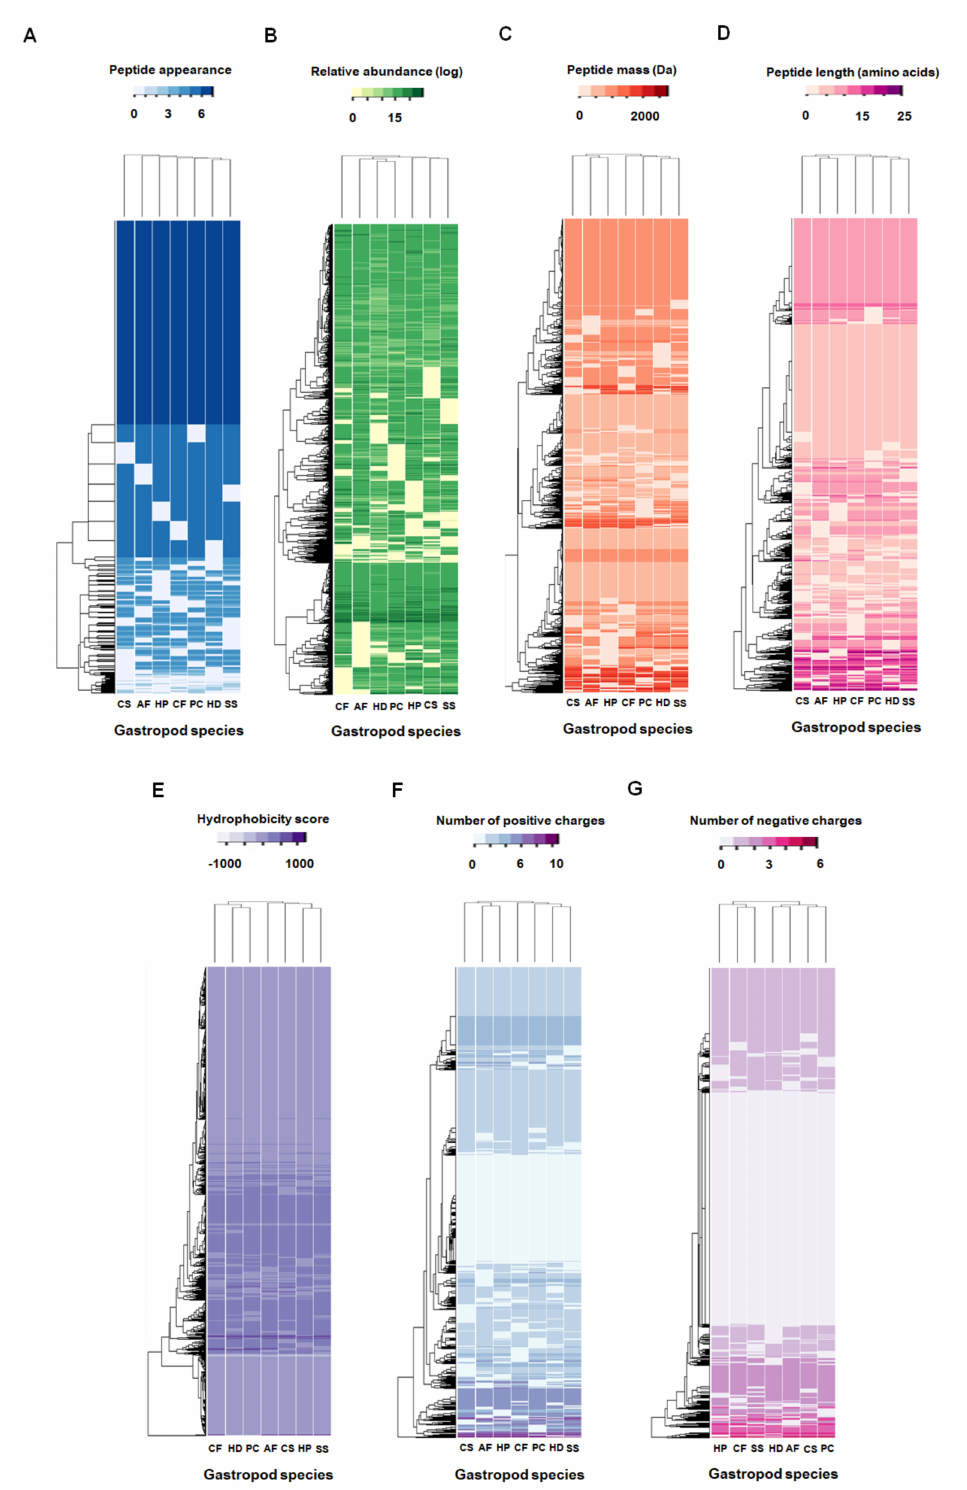
Figure 3. Clustering of peptides identified in the mucus of seven gastropod species. The peptides were clustered according to their presence ( A ), relative abundance ( B ), molecular mass ( C ), number of amino acids or length ( D ), hydrophobicity score ( E ), numbers of positively charged amino acids ( F ), and negatively charged amino acids ( G ). Columns represent gastropod species, and rows represent peptides. AF = Achatina fulica ; PC = Pomacea canaliculata ; CS = Cryptozona siamensis ; SS = Semperula siamensis ; HD = Hemiplecta distincta ; CF = Cyclophorus fulguratus ; and HP = Helix pomatia